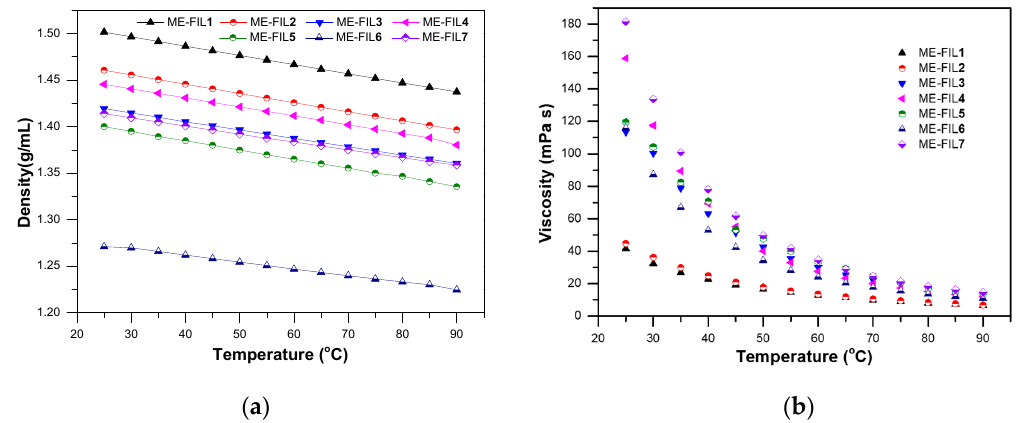
Figure 1. Temperature dependence of the physicochemical property of ME-FILs. ( a ) Dynamic density; ( b ) dynamic